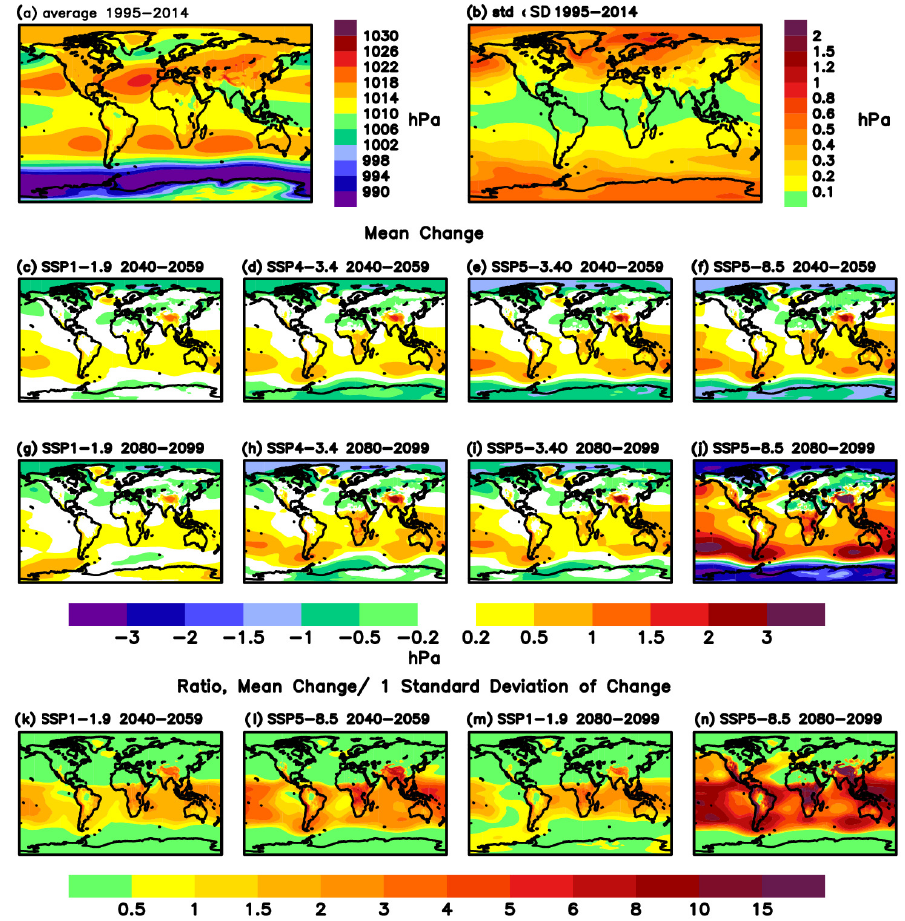
Figure 5. As Fig. 3 but for sea level pressure. Sea level pressure changes that are not marked in color are either not significant at the 95% significance level or are small (below ± 0 .